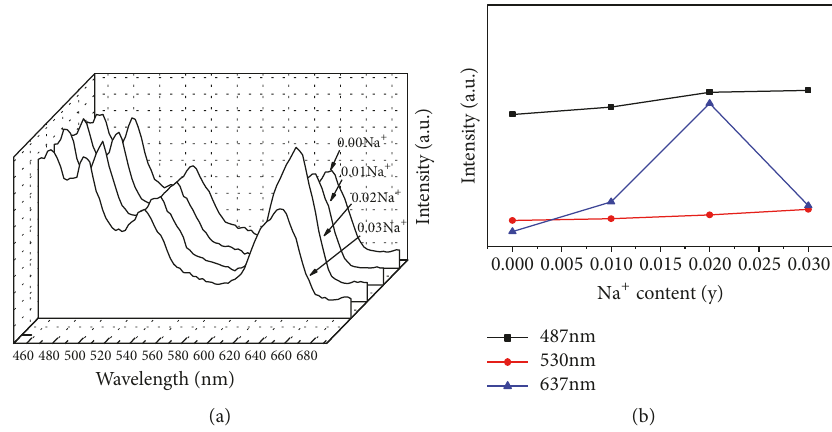
Figure 6: Emission spectra ( 𝜆 ex = 335nm) of La 0.97 PO 4 :Bi 3+ 0.03 , Na + y (y=0.00, 0.01, 0.02, 0.03) phosphors (a). The emissions intensity of 487 - y nm (blue), 530 nm (yellow), and 637 nm (red) as function of Na + doping concentration (red) (b).